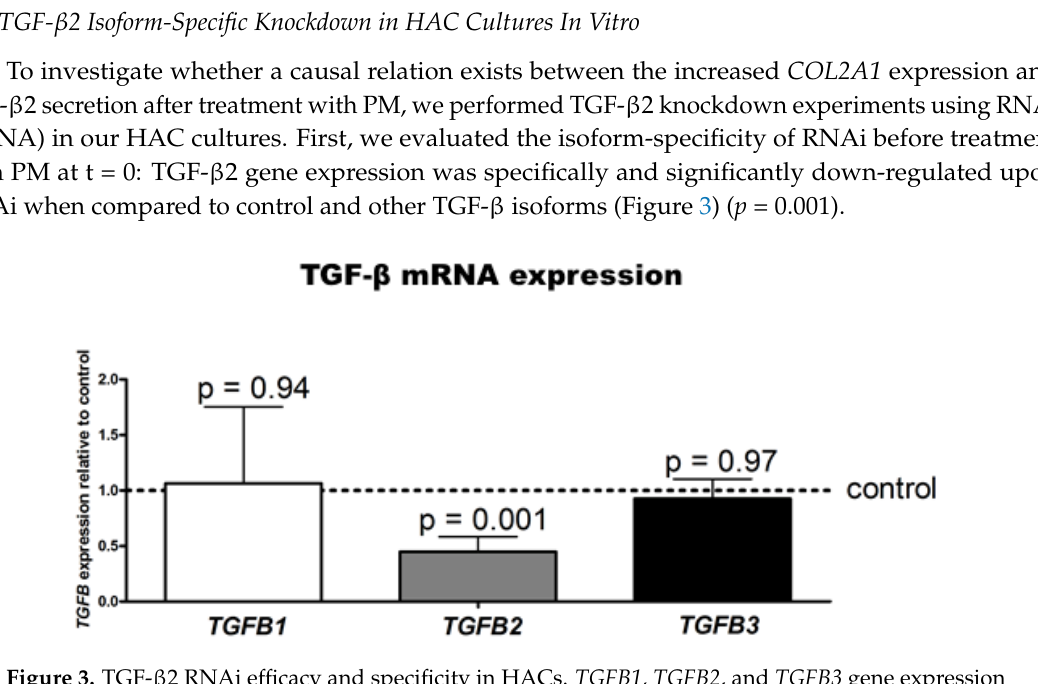
Figure 3. TGF- β 2 RNAi efficacy and specificity in HACs. TGFB1, TGFB2 , and TGFB3 gene expression was determined by RT-qPCR upon TGF- β 2-specific knockdown using transfected siRNAs (in OCM conditions). Data are the means ± standard deviation of duplicate measurements from three donors relative to control conditions (scrambled siRNA) and were normalized to housekeeper expression. Control condition is indicated by the dotted line (set to 1).